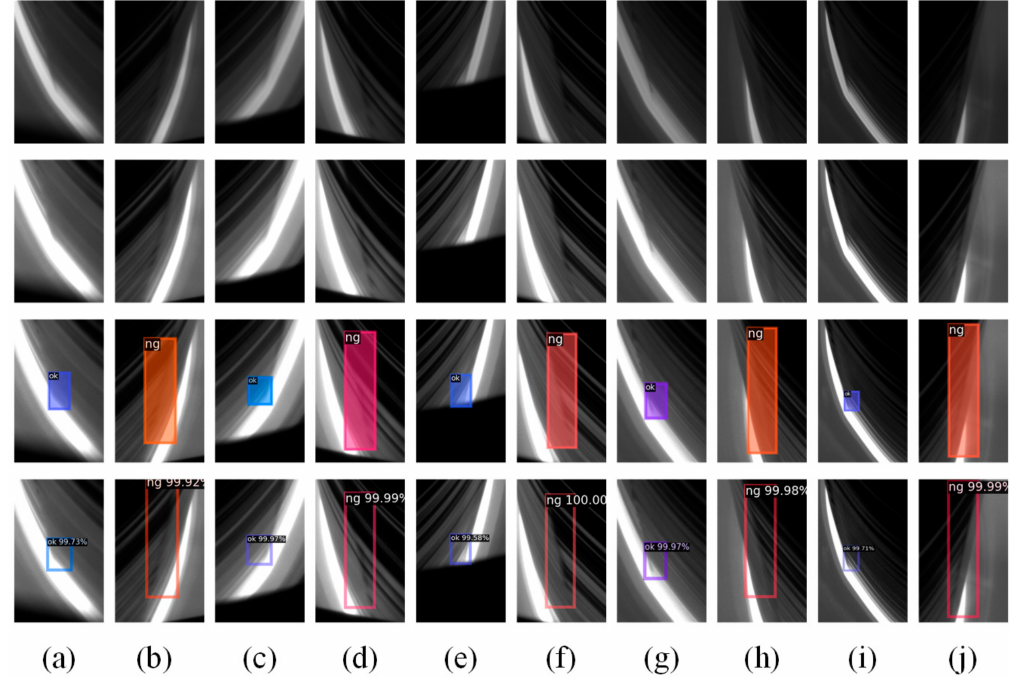
Figure 9. Model inference results. ( a – f ) results of images with occlusion; ( g – j) results of images without